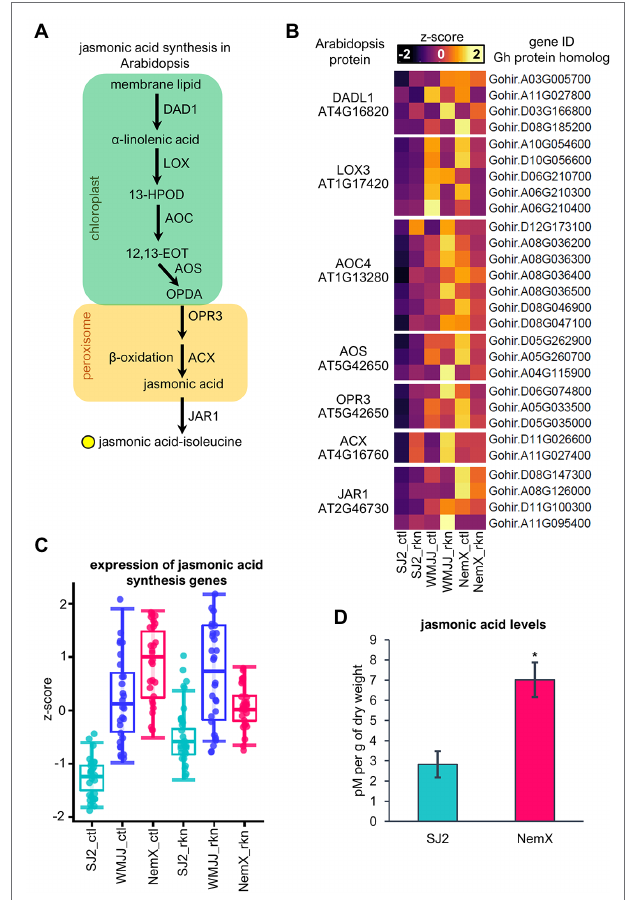
FIGURE 4 | Basal expression of jasmonic acid biosynthesis is upregulated in NemX and WMJJ with respect to SJ2. (A) Jasmonic acid synthesis in Arabidopsis. (B) Heatmap of the expression of Gh genes coding for orthologous proteins of Arabidopsis. (C) Boxplot analysis of the expression levels of jasmonic acid synthesis genes presented in (B) . (D) Quantification of jasmonic acid in SJ2 and NemX cotton plants using UHPLC coupled to MS. Jasmonic acid levels were determined in picomoles (pM) per gram of dry weight. Student’s t -test was performed to determine statistically significant differences ( n = 3) which are indicated with an asterisk ( p